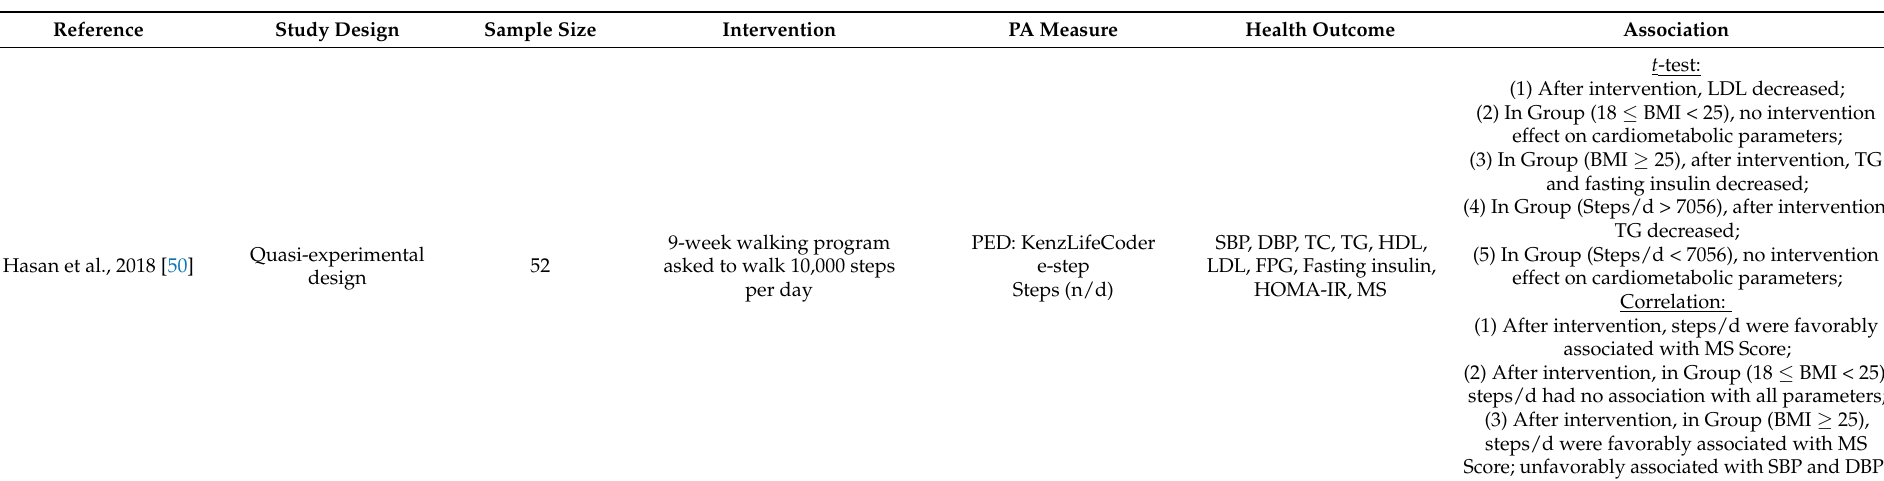
Table 2. Characteristics of intervention